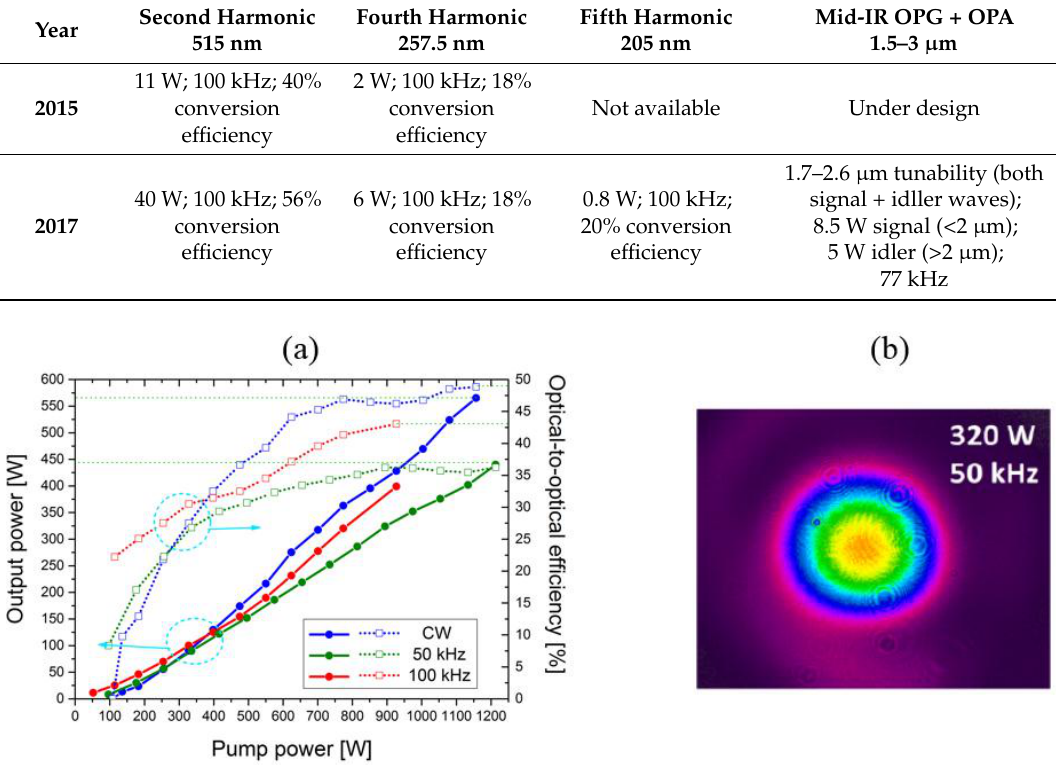
Figure 2. Typical performance of the actual status of the Perla C amplifier with a ring cavity: ( a ) Output power and optical-to-optical efficiency in pulsed operation (50 and 100 kHz) compared with continuous wave (CW) performance of the ring cavity; ( b ) nearly diffraction-limited beam profile (Gaussian, normalized, red – peak power, blue – low power, violet - background) at average power of 320 W and 50 kHz repetition rate as used for experiments (M 2 < 1.8).